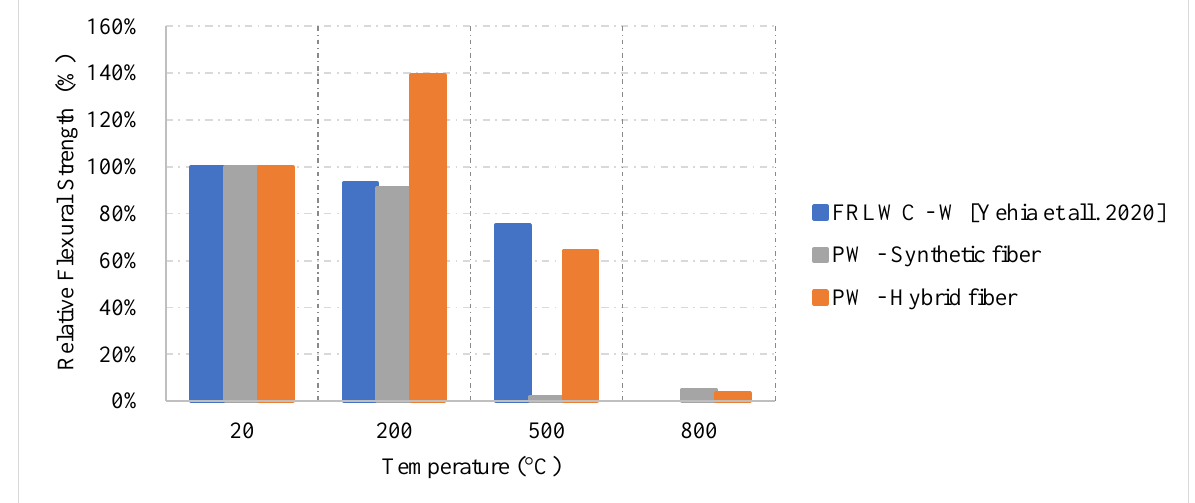
Figure 24. Effect of different fibers on the relative flexural strength of water cooled FRC. S: Steel fiber, HF: Hybrid fiber, SYF: Synthetic fiber, OR: Ongoing Research [64]. Table 4. Important parameters of different studies on FRC